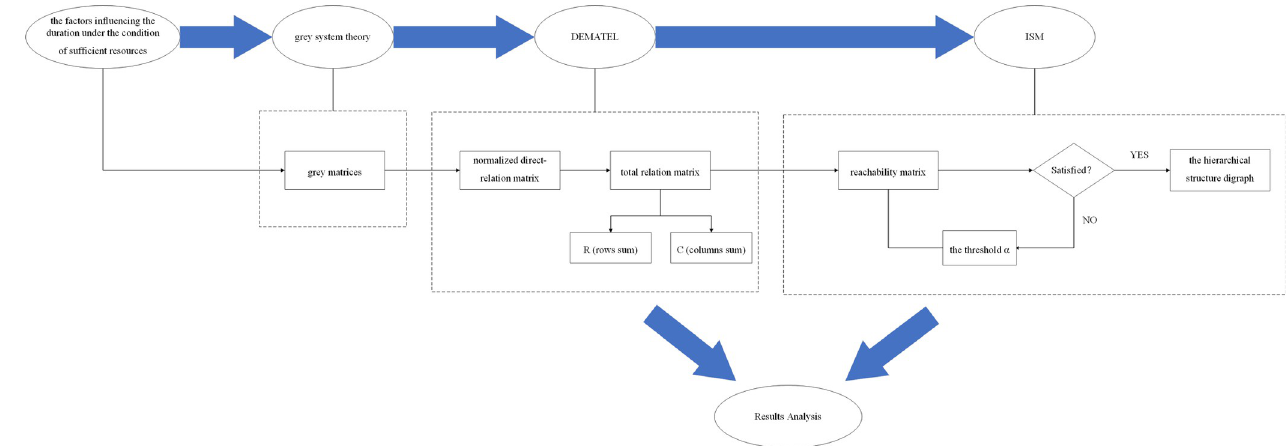
Fig 1. The process of Grey-DEMATEL-ISM analysis model.